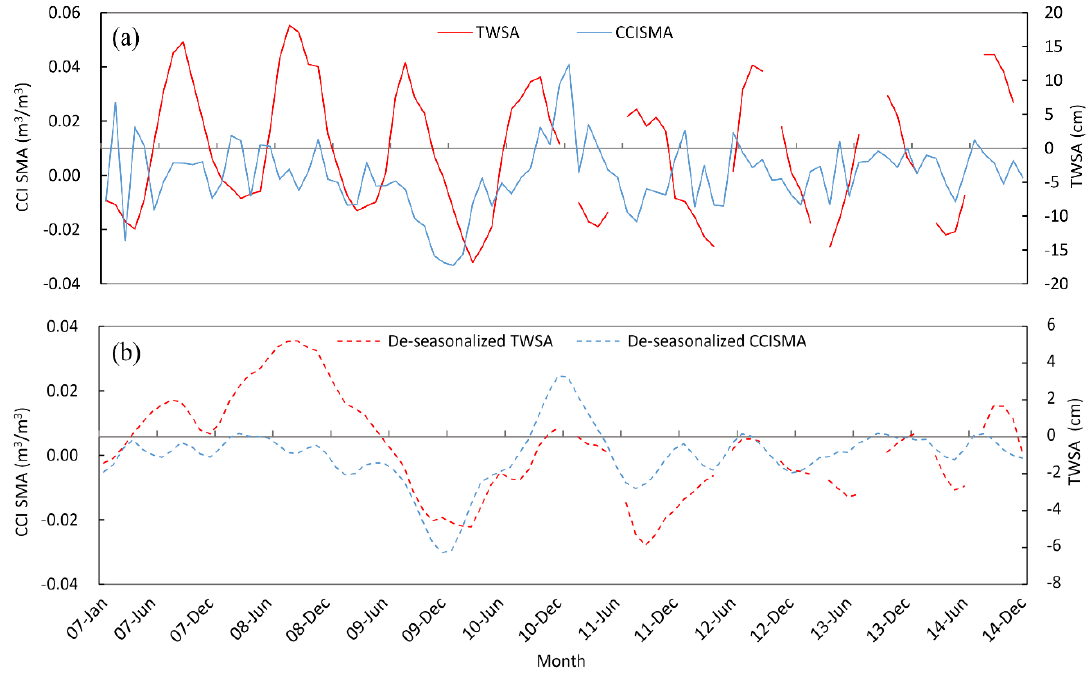
Figure 6. ( a ) Monthly average Total Water Storage Anomalies and Soil Moisture Anomalies from 2007 to 2014; the solid red line represents the de-seasonalized Total Water Storage Anomalies; the solid blue line represents the de-seasonalized Climate Change Initiative (CCI) Soil Moisture Anomalies. ( b ) Monthly average de-seasonalized and smoothed Total Water Storage Anomalies and Soil Moisture Anomalies from 2007 to 2014 in Yunnan Province. The month without data is vacant.